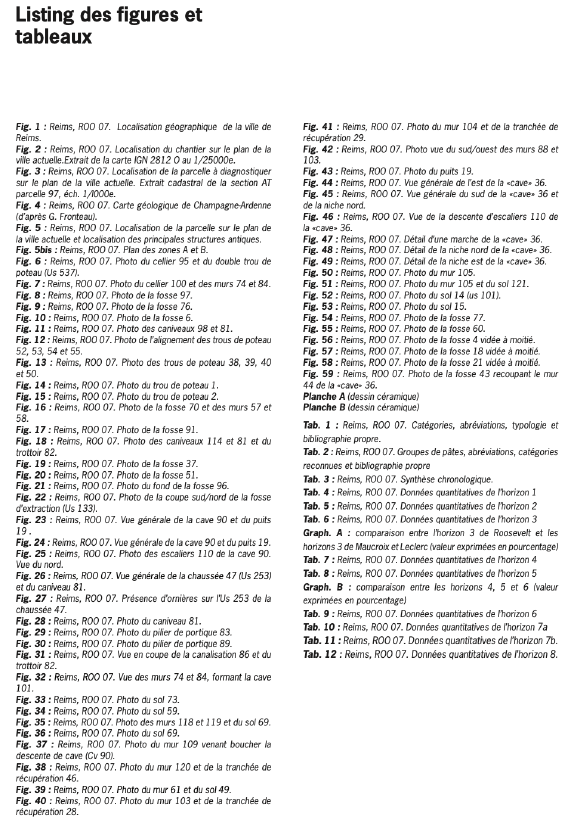
Figure 6 : list of figures in an excavation report (Lefis, 2011) This report contains pictures of the first case, which is not the case in other reports. This first case allows to associate 117 captions on 174 pictures. The second, more general case should allow to associate most of the remaining cases. After management of the general case, 149 figures out of 174 were associated with a legend (86%). Among the 149 associations, three are wrong because of a problem of order or annotation and parasitic legends. This represents 98% of correct associations among those made (149) and 84% among the correctly extracted pictures (174). The association of legends to pictures is still to be generalized, as some excavation reports do not contain a list of figures and the first case is not very common. Some ways of improvement have already been identified for an iteration of this part of the study.